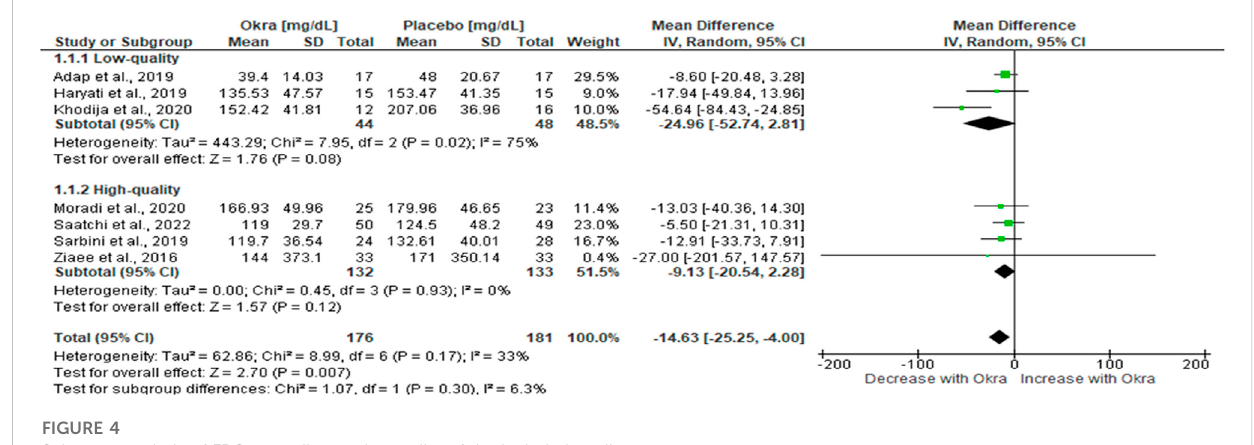
FIGURE 4 Subgroup analysis of FBG according to the quality of the included